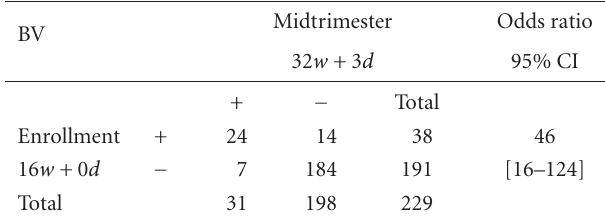
Table 1: Dynamics of bacterial vaginosis (BV) diagnosed by Amsel’s criteria from enrollment until delivery ( N =